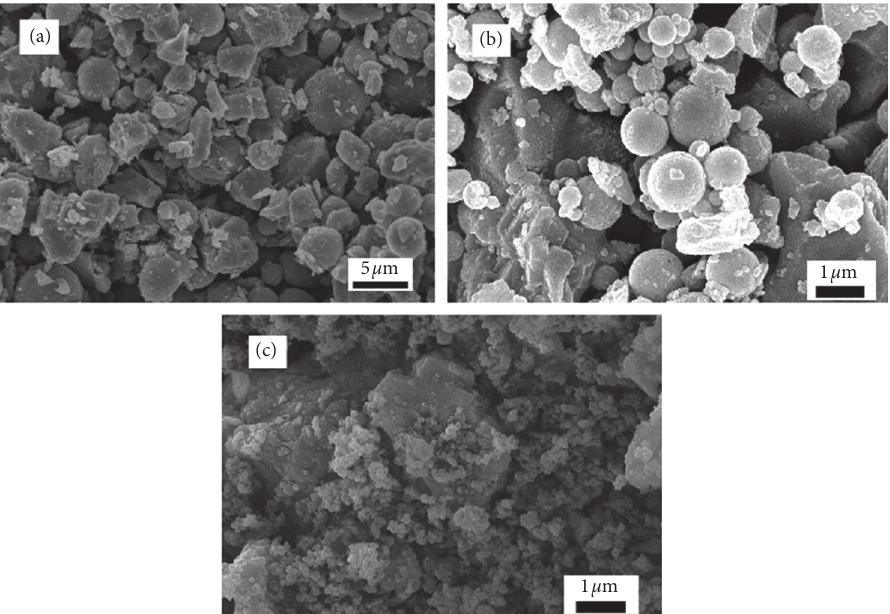
Figure 4: SEM images of thermite samples: (a) 5 μ m Al +micron-MnO (c) nano-Al+micron-MnO 2 thermite